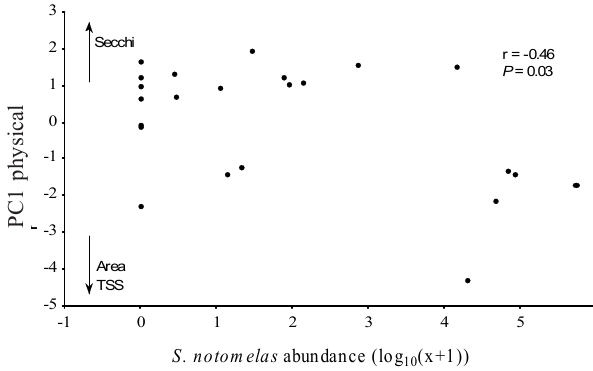
Fig. 3 . Scatterplot of the abundance of Serrapinnus noto- melas and the scores of axis 1 of the principal components analysis (PCA) that summarized physical variables. Variables that more contributed to formation of the axis (arrows) are also given. TSS = Total suspended solids.